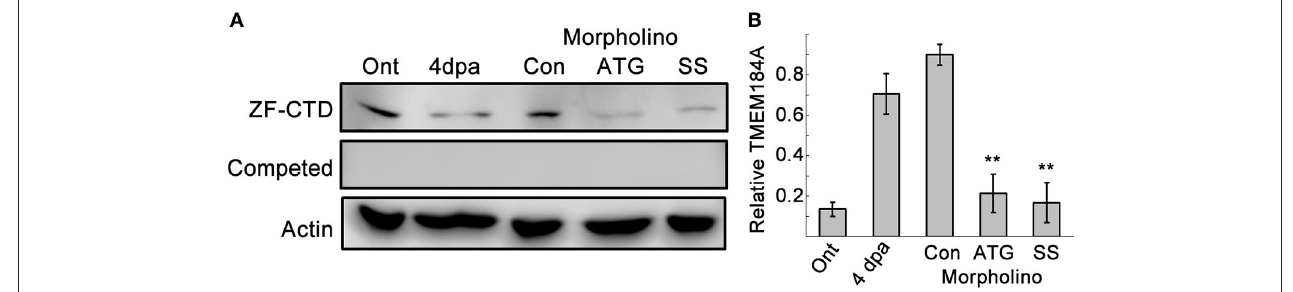
FIGURE 2 | Two MOs against Tmem184a sufficiently knock down protein expression. (A) Validation of Tmem184a knockdown by western blotting of ontogenic and 4 dpa fin lysates with the ZF-CTD antibody. (B) Quantitation of Tmem184a band intensity/actin band intensity. Data are representative of more than three independent experiments with 8–12 fish injected per experiment. Graphs are shown as average ratio ± S.E.M. ** p < 0.01 compared to Con